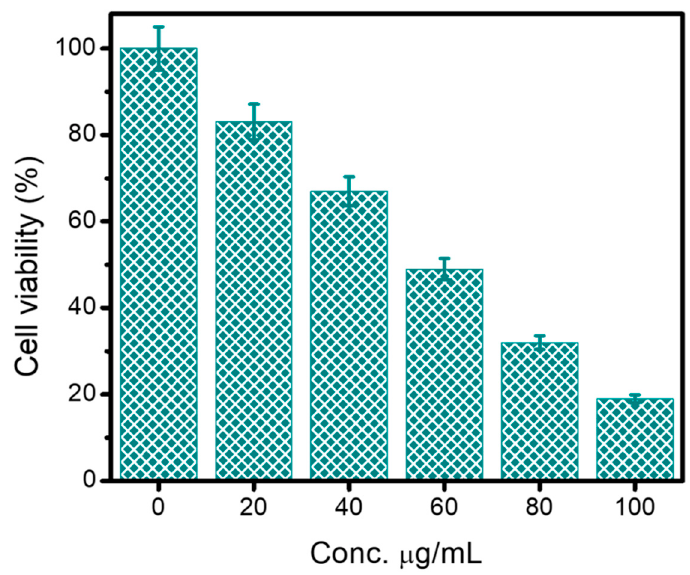
Figure 7. Cytotoxicity activity of Ca-AgNPs at various concentrations (µg/mL).